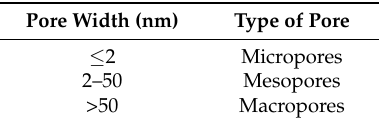
Table 1. Pore classification by the IUPAC according to the